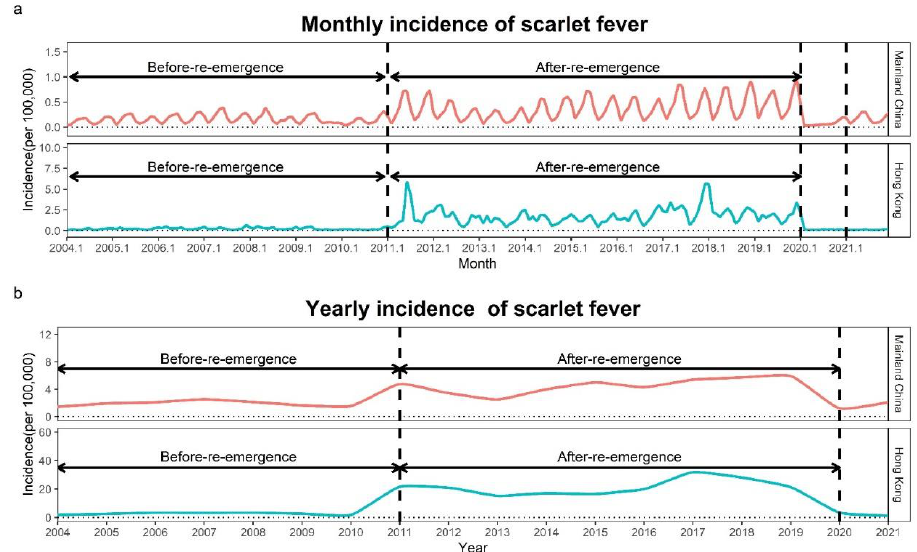
Figure 1. Yearly and monthly incidence rates (1/100,000) of scarlet fever in the period 2004–2021. ( a ) Monthly incidence of scarlet fever; ( b ) yearly incidence of scarlet fever. Before-re-emergence: 2004–2010; after-re-emergence: 2011–2019.